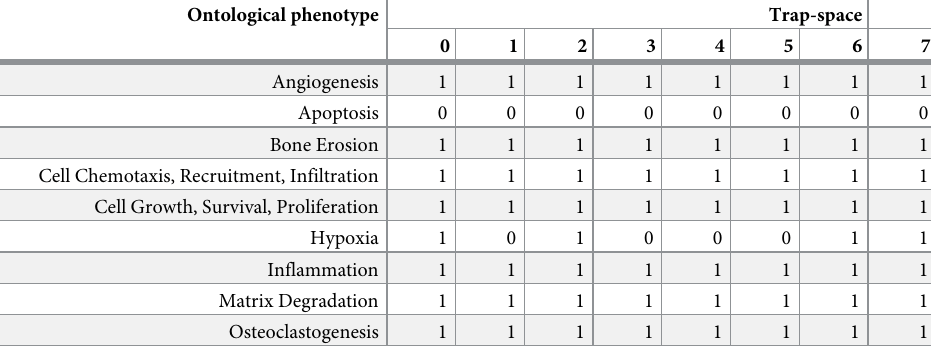
Table 3. Projection of the RASF model’s trap-spaces on its nine ontological phenotypes. Ontological